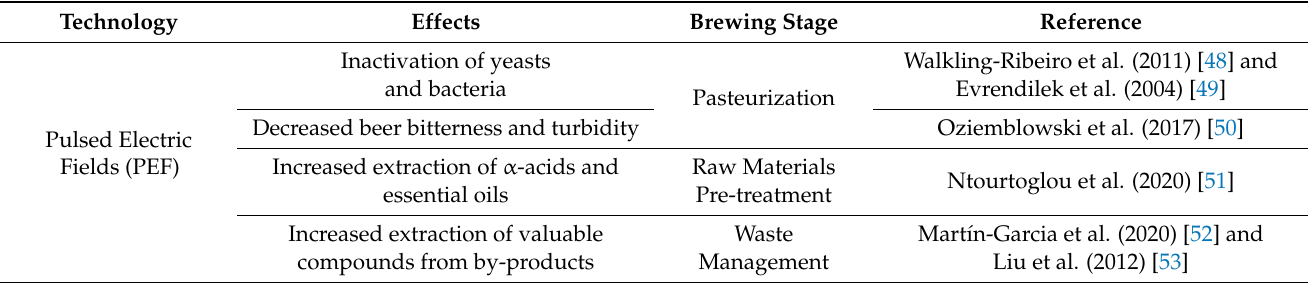
Table 1. Summary of the main effects of each technology in the different stages of the brewing